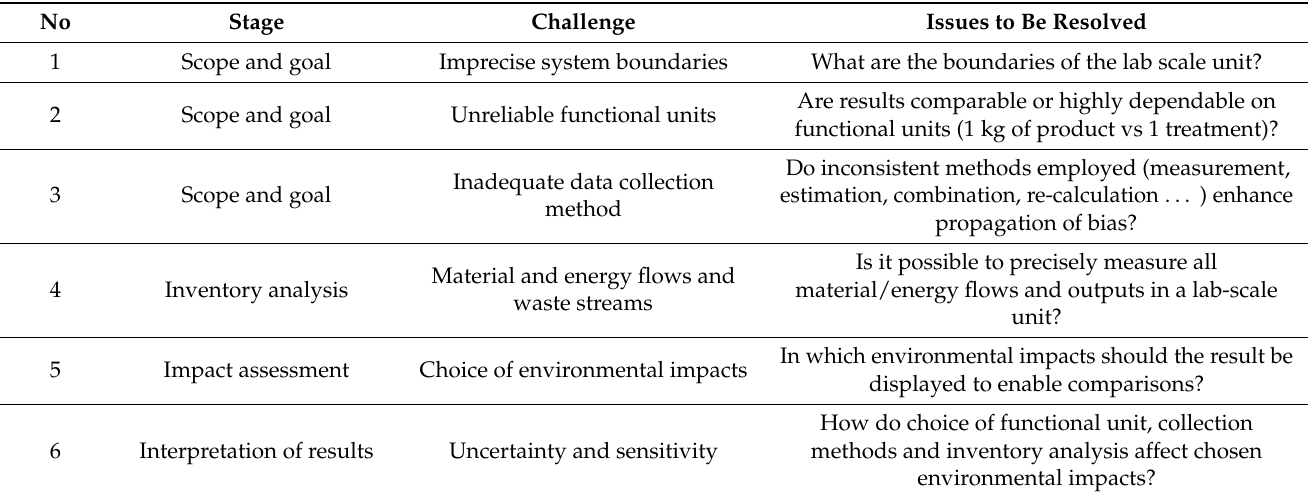
Table 3. Challenges in performing a LCA of nonthermal food processing